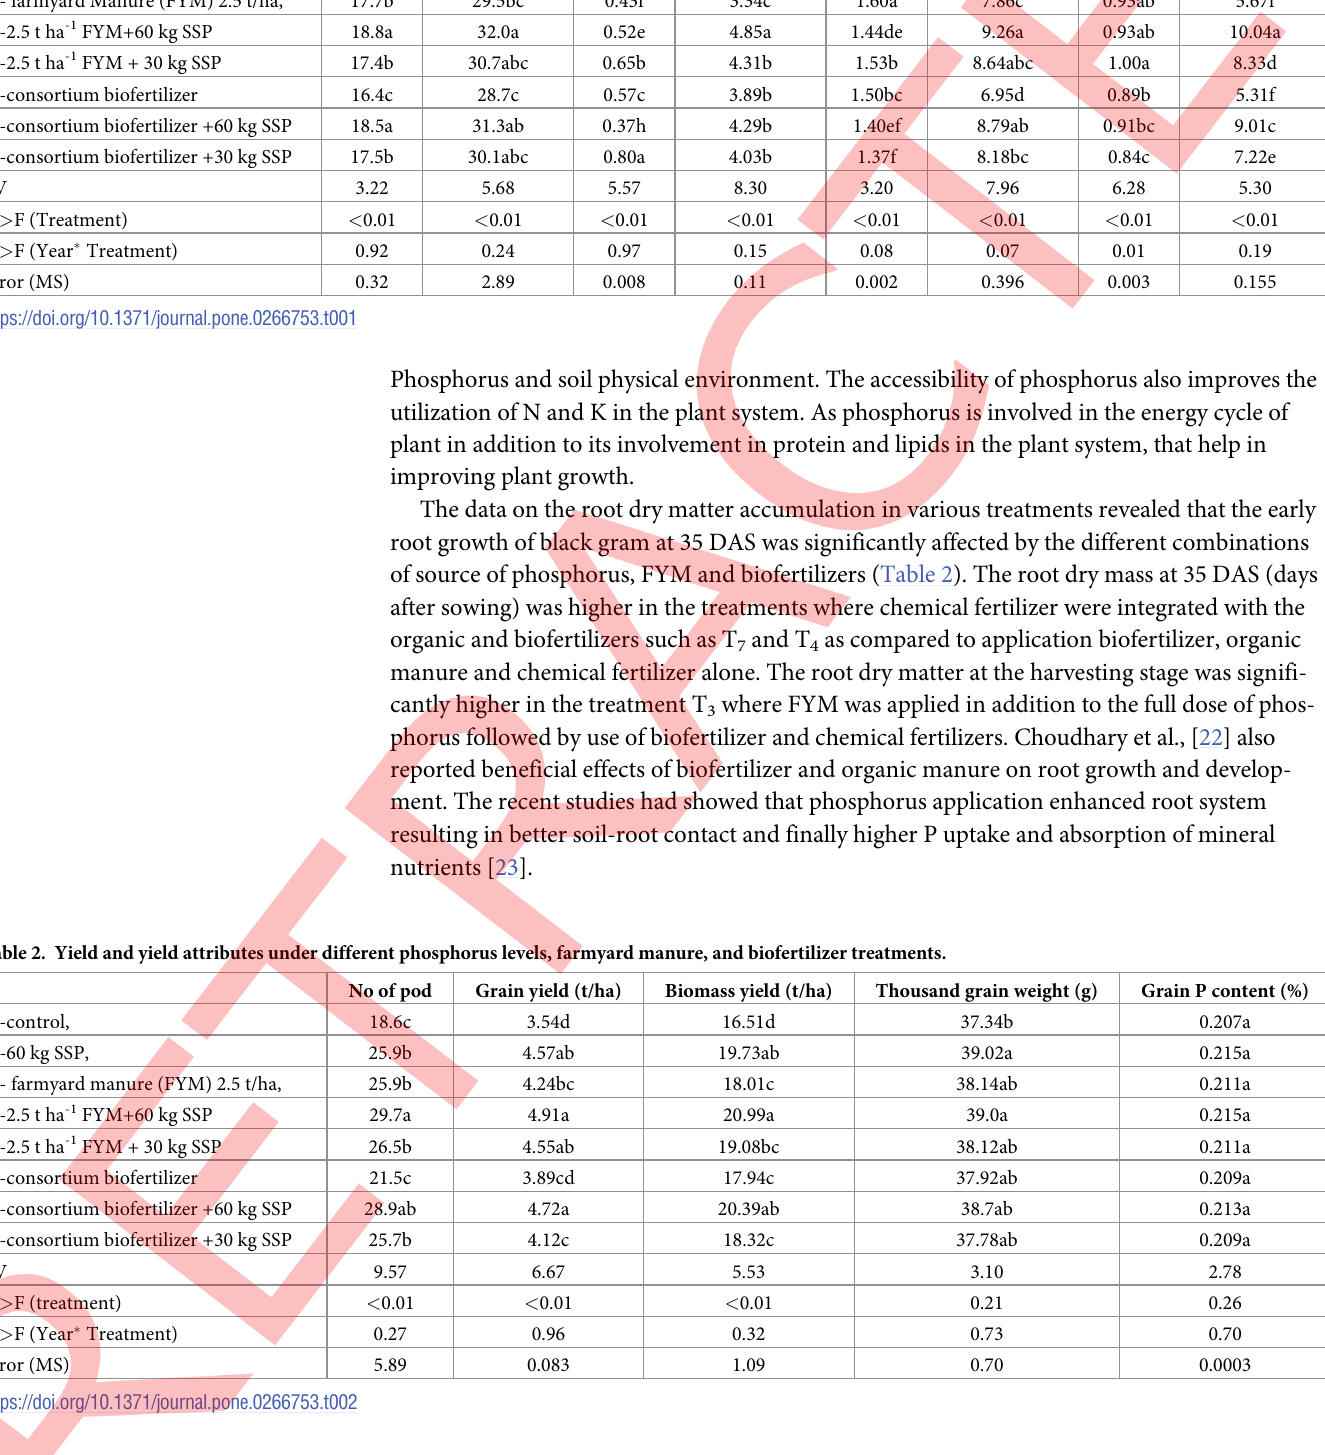
Table 1. Effect of phosphorus levels, farmyard manure and biofertilizer on plant height and dry matter accumulation. Treatments